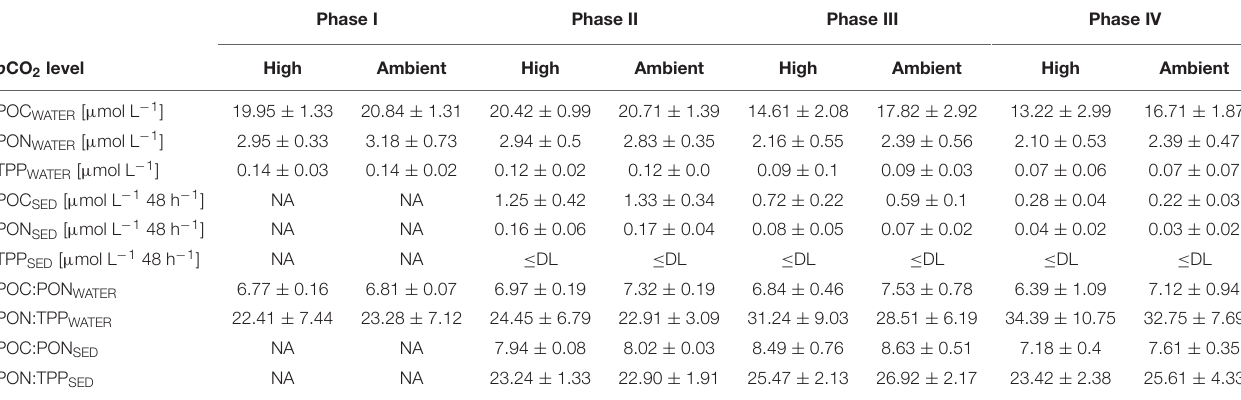
TABLE 3 | Summary of average POM WATER , and POM SED values as well as their elemental ratios under the different p CO 2 levels and the four phases of the